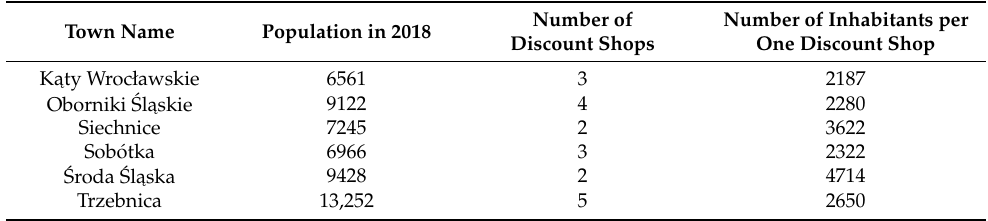
Table 1. The number of traditional shops and discounts in small towns. Authors’ own study based on data made available by Statistics Poland Data Applied Computer Science Centre.